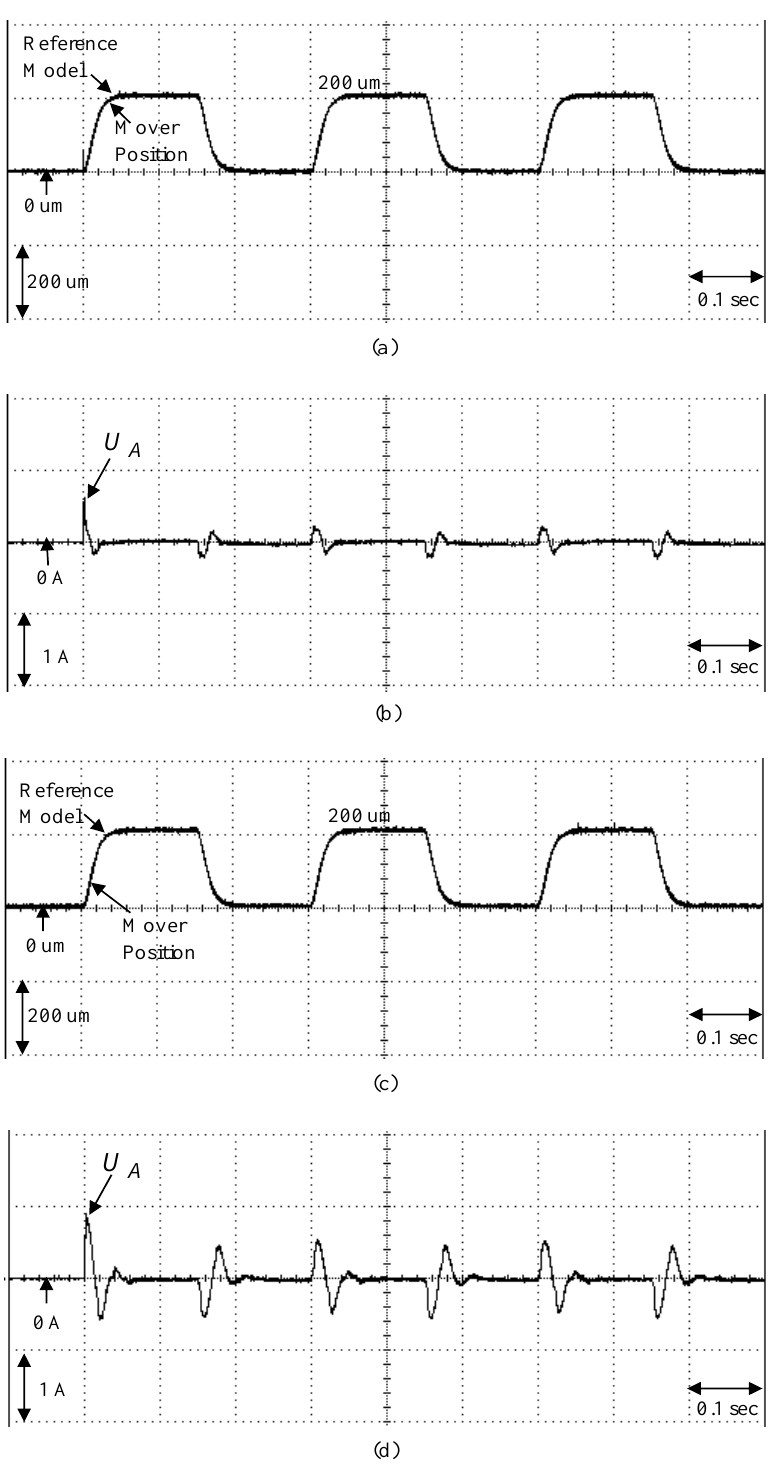
Figure 9. Experimental results of the micrometer backstepping control system using an amended recurrent Gottlieb polynomials neural network and altered ant colony optimization (AACO) with the compensated controller for the periodic step command: ( a ) mover position in the rated case; ( b ) control intensity in the rated case; ( c ) mover position in the parametric variation case; ( d ) control intensity in the parametric variation case.